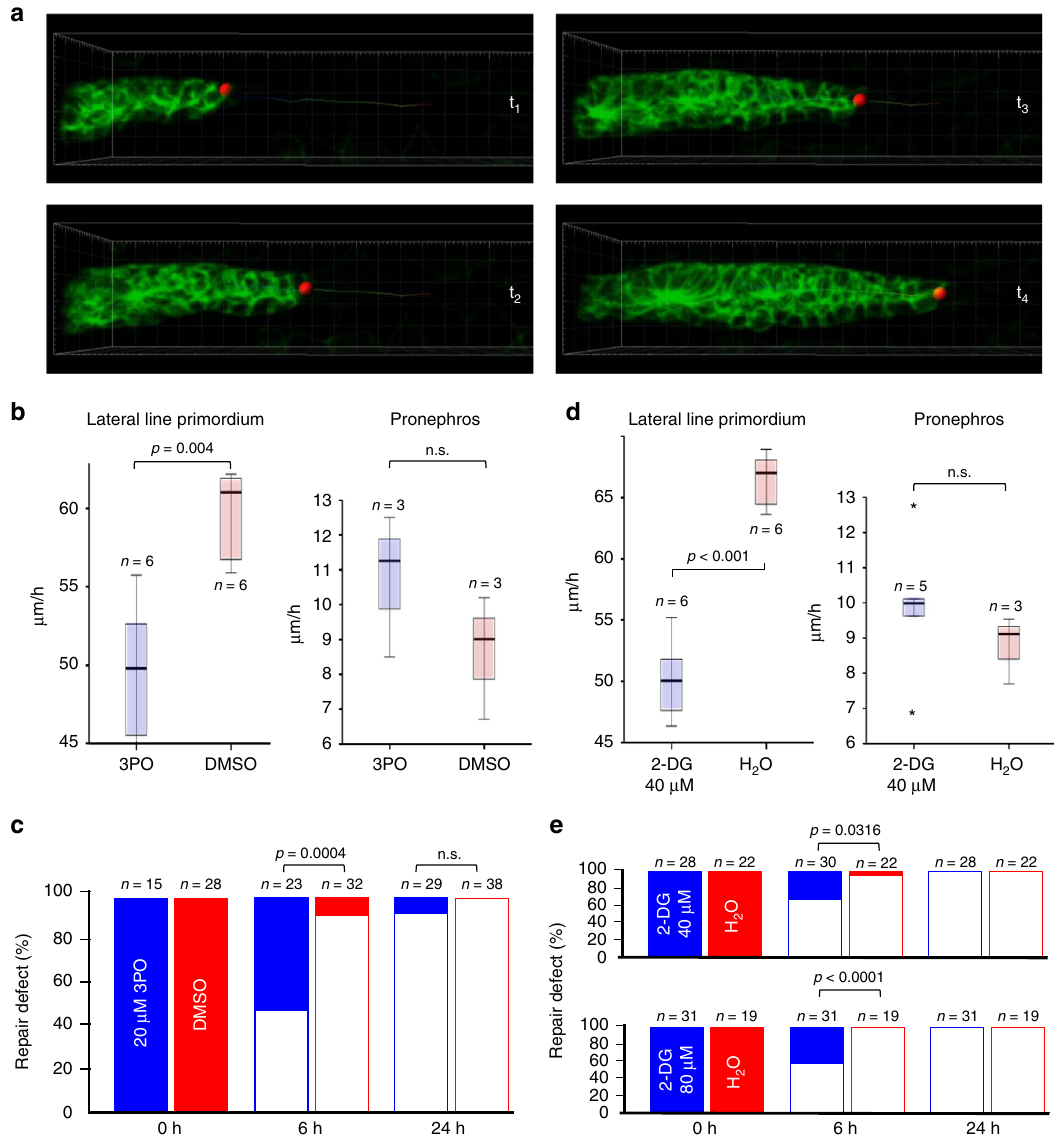
Fig. 9 Inhibition of glycolysis slows migration. a Depicted are frames from Supplementary Movie 10, demonstrating the analysis of migration speed in the posterior Lateral Line Primordium (pLLP). A similar imaging approach was used to determine the speed of migrating cells in the zebra fi sh pronephros. b The small molecule 3-(3-pyri-dinyl)-1-(4-pyridinyl)-2-propen-1-one (3PO) at concentrations that had no recognizable developmental effects (20 µ M) delayed pLLP migration, but did not affect pronephros cell migration. The box plots represent the median, the fi rst and third quartile (boxed area), and 1.5× interquartile range (whiskers) (n.s., not signi fi cant; t -test). c 3PO delayed the repair of a pronephros injury determined at 6 h, but no effect was observed 24 h after the injury (Fisher ’ s exact test). d The glucose analog 2-deoxy-D-glucose (2-DG) at 40 µ M slowed pLLP migration similar to 3PO, but had no effect on pronephros collective cell migration. The box plots represent the median, the fi rst and third quartile (boxed area), and 1.5× interquartile range (whiskers) (n.s., not signi fi cant; t -test). e While almost all injuries were repaired 6 h after wounding of control embryos, 40 µ M 2-DG reduced the number repaired injuries. The graphs represent the summary of at least three independent experiments (Fisher ’ s exact